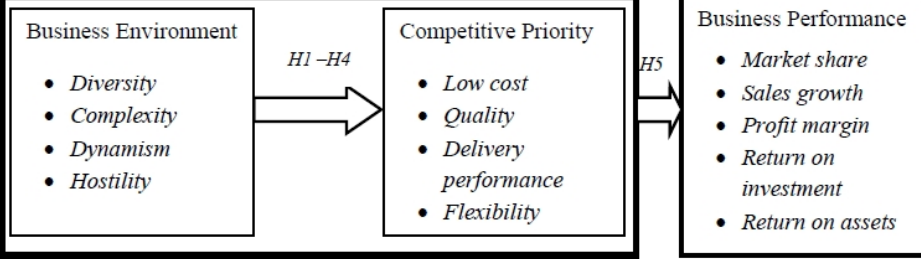
Figure 1. Proposed environment-strategy-performance